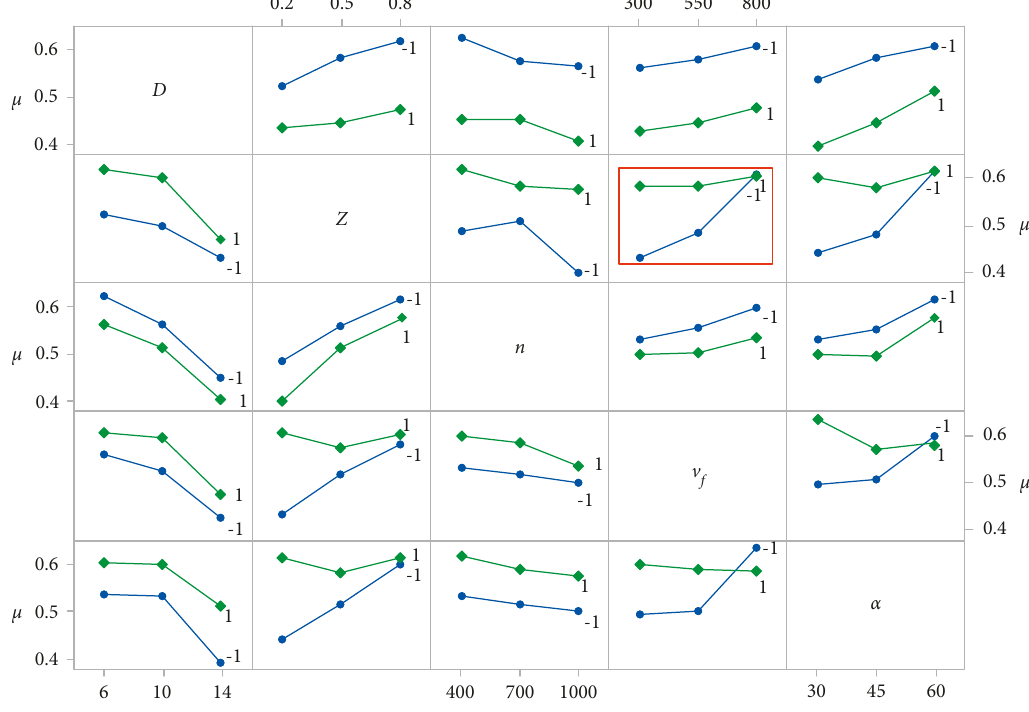
Figure 16: Interaction plot of two